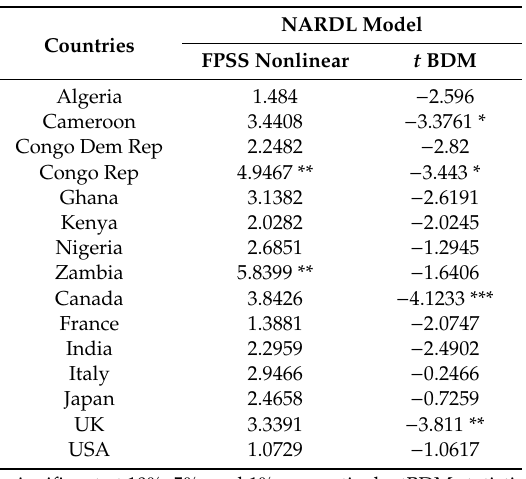
Table 7. Cointegration test